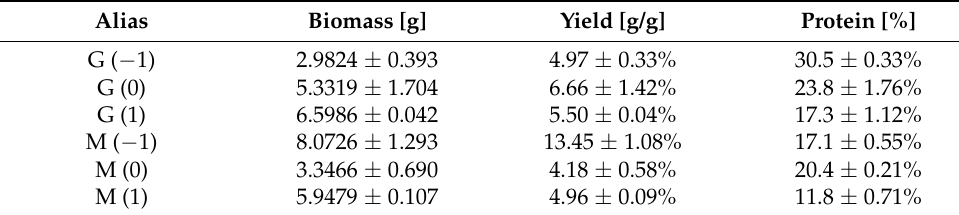
Figure 1. Growth curve for A. oryzae . Table 3. Biomass and protein production.